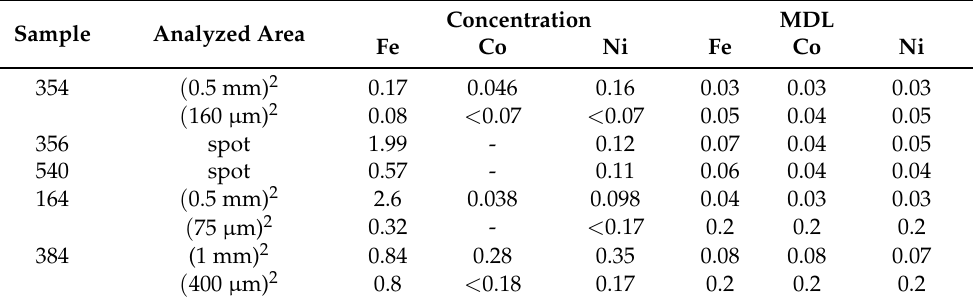
Table 3. Main magnetic impurities content (in µ g/g) measured by particle-induced X-ray emission (PIXE) of the natural diamond samples. The selected areas for the measurements are included. The spot area was 9 µ m 2 . MDL, minimum detectable limit.